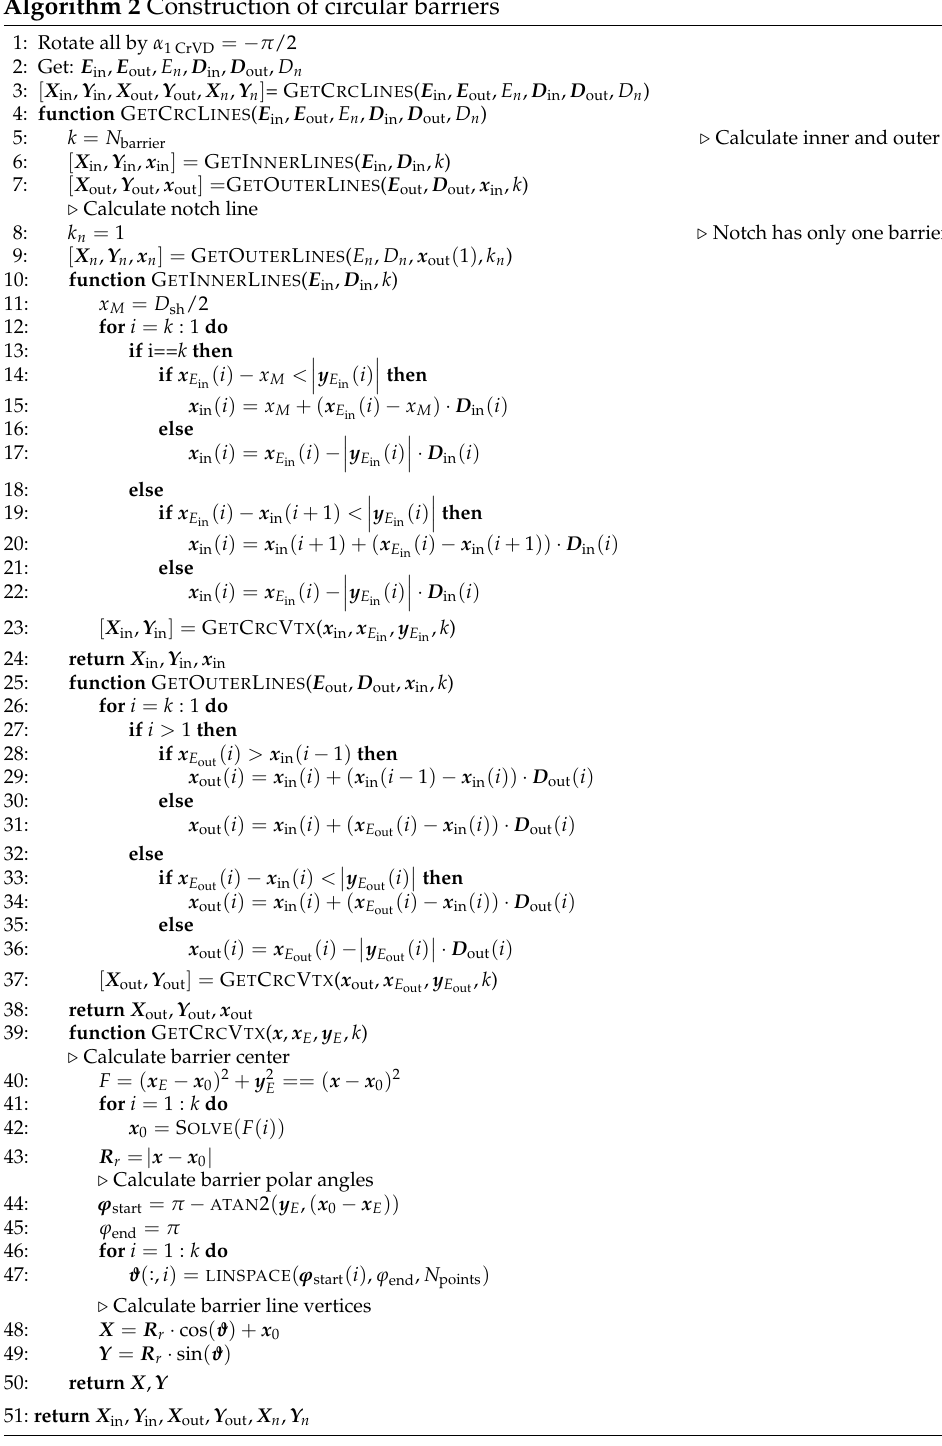
Algorithm 2 Construction of circular